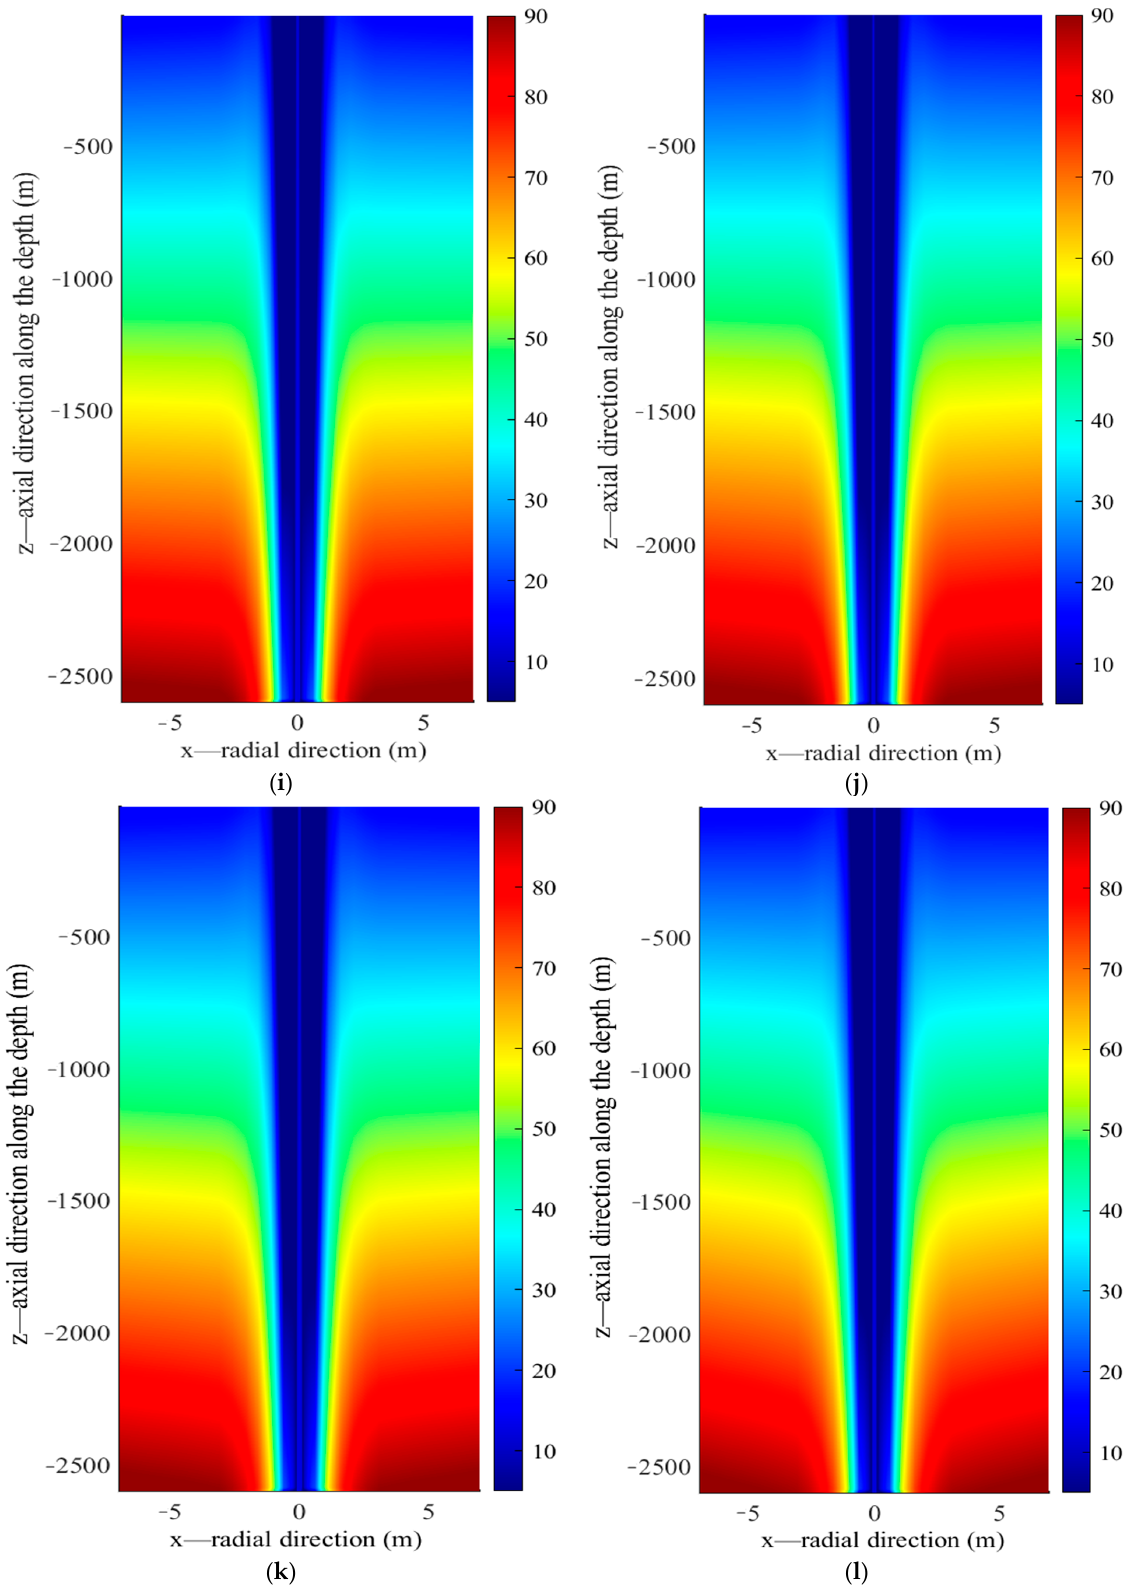
Figure 16. Rock temperature evolution underground during the 120 days of discharging after high temperature heat storage: ( a ) 1 day; ( b ) 5 day; ( c ) 10 day; ( d ) 20 day; ( e ) 30 day; ( f ) 40 day; ( g ) 50 day; ( h ) 60 day; ( i ) 70 day; ( j ) 80 day; ( k ) 90 day; ( l ) 120 day.